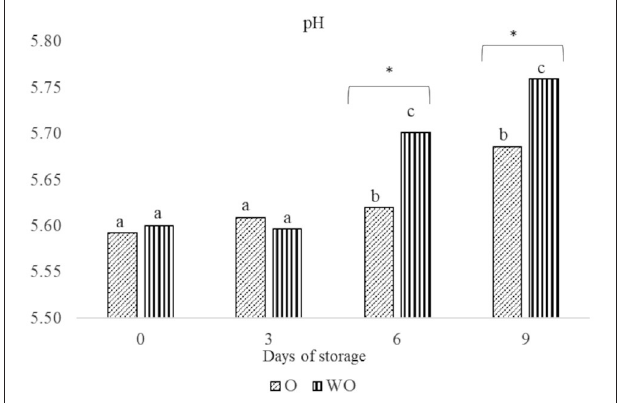
FIGURE 1 | Effect of treatment with (O) and without (WO) essential oils on Marchigiana beef meat pH during storage time (0, 3, 6, and 9 days). Different letters on the top of the bars denote significant differences ( P < 0.05) between experimental groups on days of storage. Asterisk denotes significant differences in the same group between the meat with (O) and without (WO) essential oils ( P <